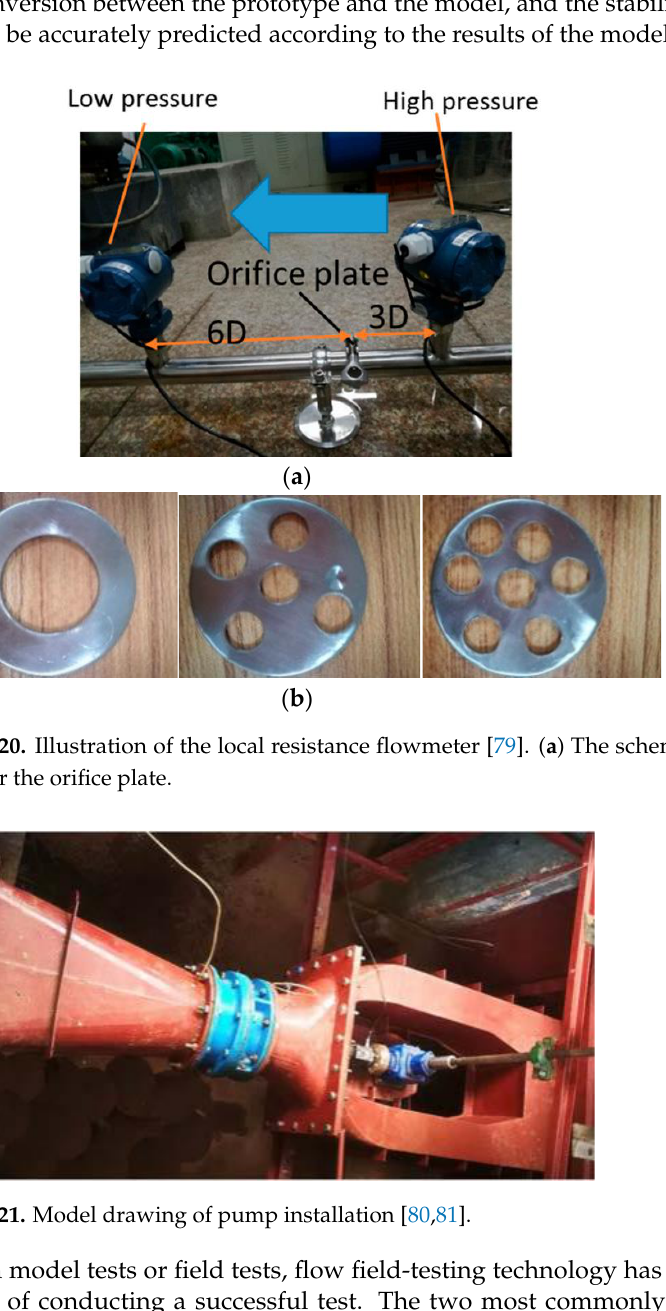
Figure 20. Illustration of the local resistance flowmeter [79]. ( a ) The schematic diagram. ( b )Three sizes for the orifice plate.